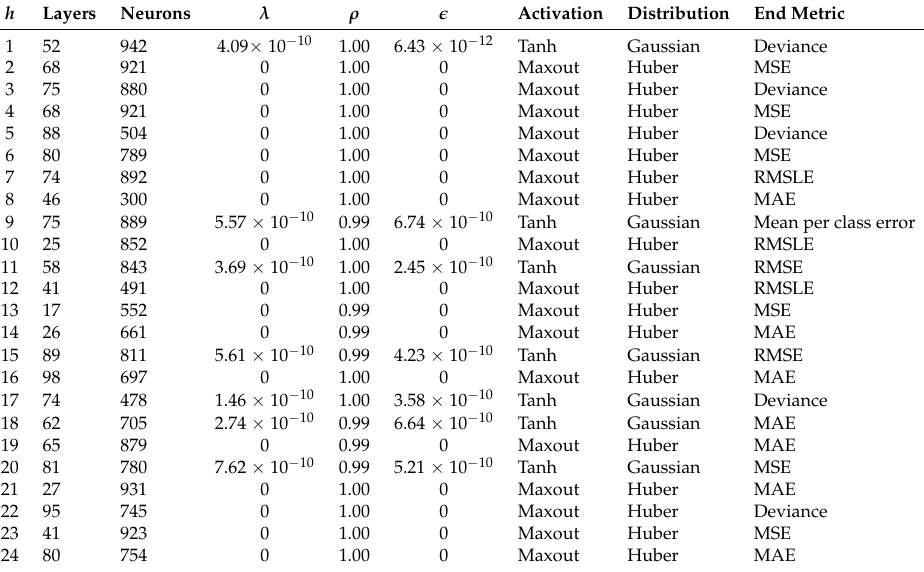
Table 4. Parameters found by the GA for w =